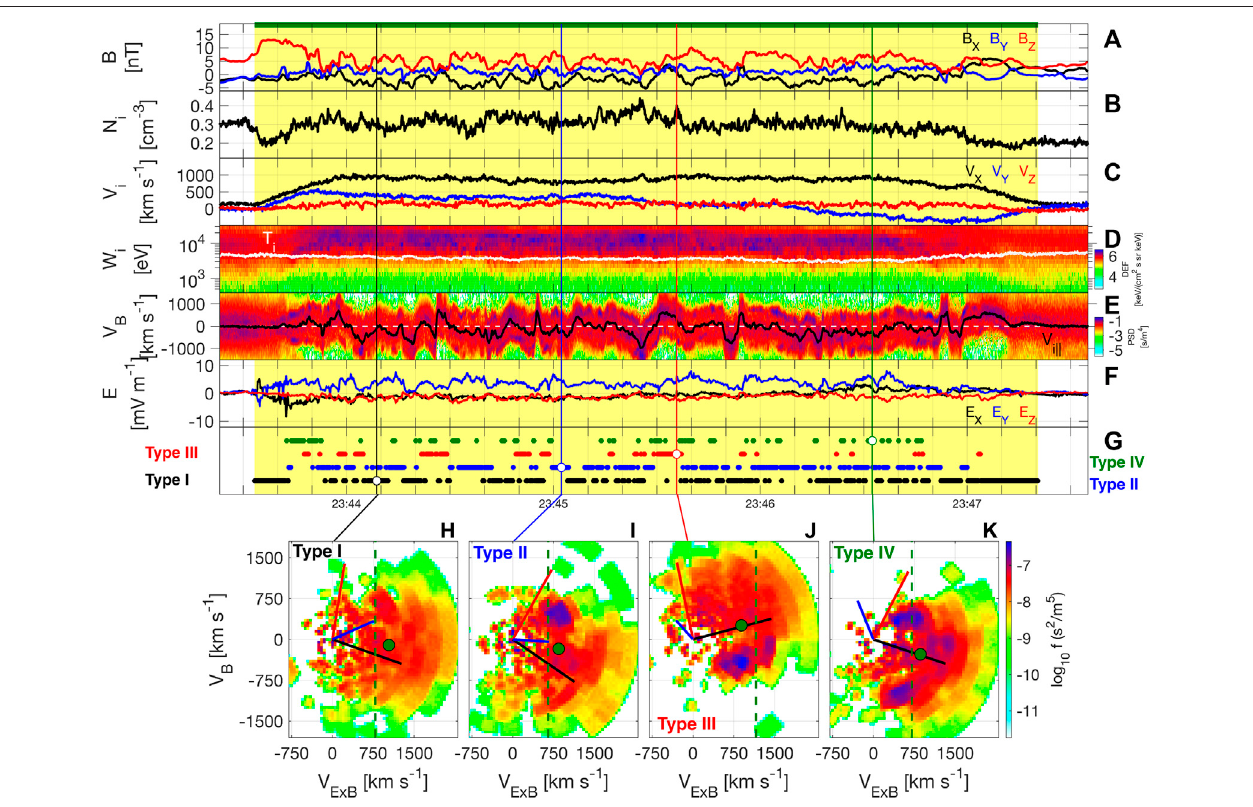
FIGURE 3 | Four types of ion velocity distribution functions (VDFs) in the earthward ion jet. (A) B . The green horizontal bar denotes the ion jet interval. (B) N i . (C) V i . (D) FPI ion omnidirectional differential energy fl ux with ion temperature (white curve). (E) Reduced ion VDF integrated over the directions perpendicular to the magnetic (cid:2) 0. (F) Electric fi eld E . (G) IonVDFtypes insidetheionjet. (H) – (K) fi eld. Theblacksolidcurve showstheparallel ionbulkspeedV i (cid:3) ,andthewhitedashed linedenotesV i (cid:3) Examples of the four-type ion VDFs at times indicated by the four vertical lines in (A) – (G) . (H) – (K) are in the same format with Figures 2G – I .